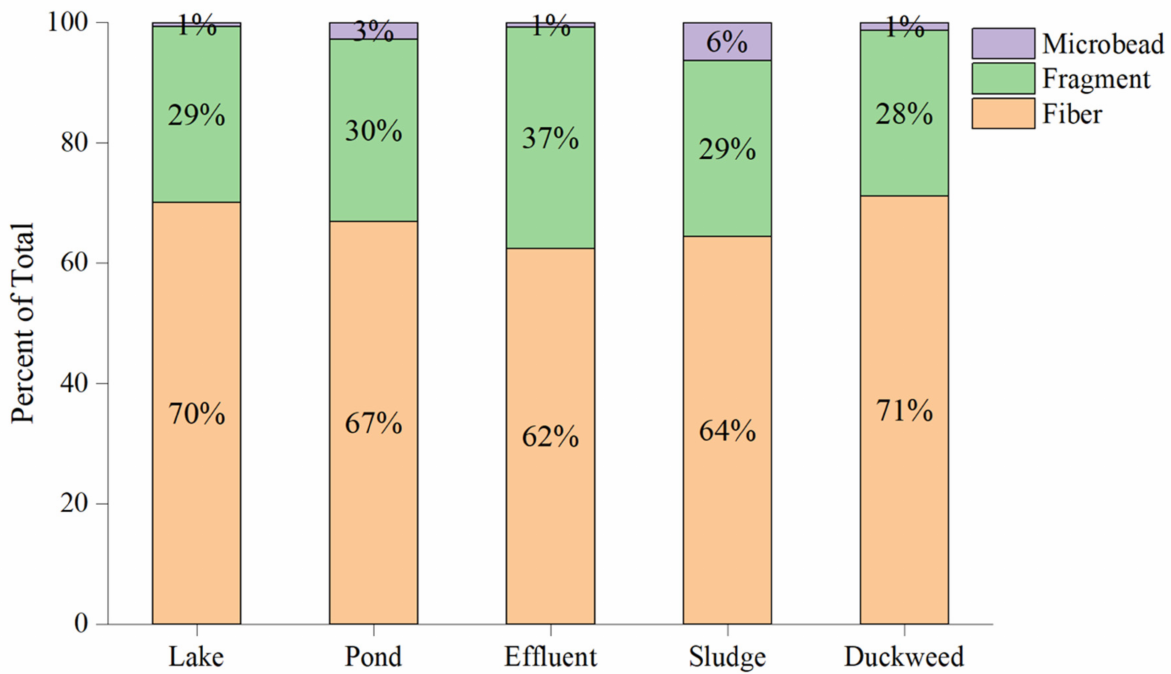
Figure 2. Microplastic abundances in four different compartments in the waste stabilization pond (pond water, effluent water, sludge, and duckweed) and in water from an adjacent lake during warm and cold seasons. Error bars = ± 1 standard deviation.